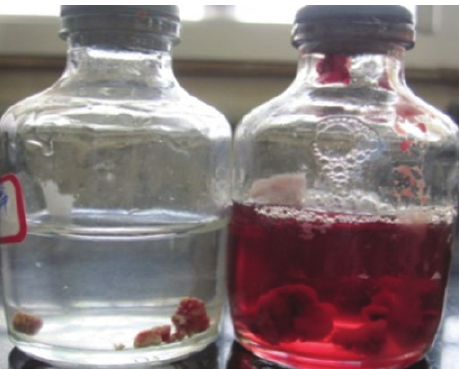
Figure 13: Lesional tissue stored in formalin for histopathological examination.